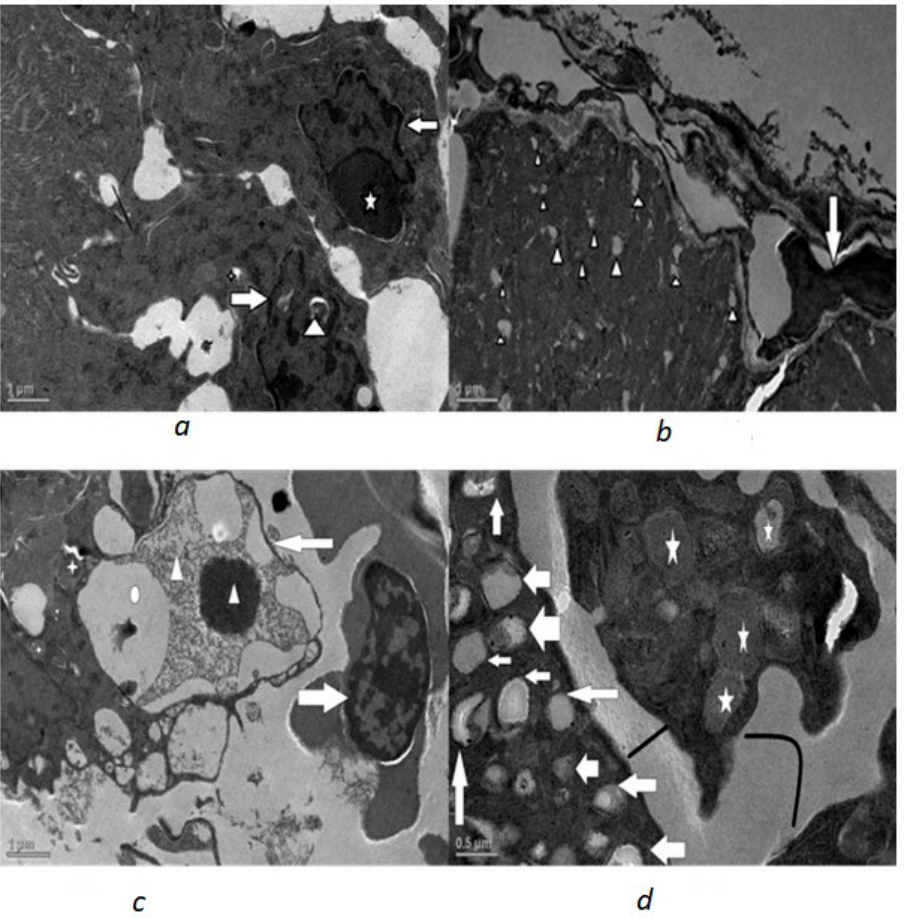
Figure 4. Transmission electron micrographs of 0.015 mL/L Dimethoate exposed renal cells exposed for 72 h: ( a ) highly deformed nucleus (white filled arrow) with apoptotic body (big star), cytoplasmic vacuole (thick black line), vacuolated mitochondria (small star) (scale 1 µm); ( b ) severe cytoplasmic vacuolization (star head), deformed nucleus(white filled arrow) (scale 1 µm); ( c ) deformed nucleus (white filled arrow) with nuclear vacuoles (O) and condensed chromatin (arrow head) and nucleolus (scale 1 µm); ( d ) highly deformed mitochondria (star), increased intercellular space (thick straight and curved line), and extreme cytoplasmic vacuolation (white filled arrow) (scale 0.5 µm).